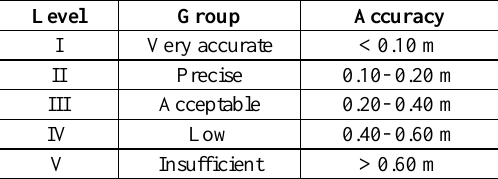
Table 3. Details’ accuracy classes